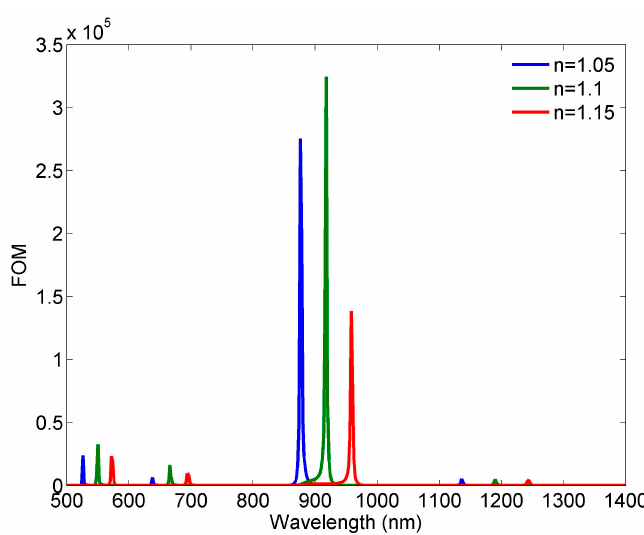
Figure 7. Calculated FOM for different refractive indices.